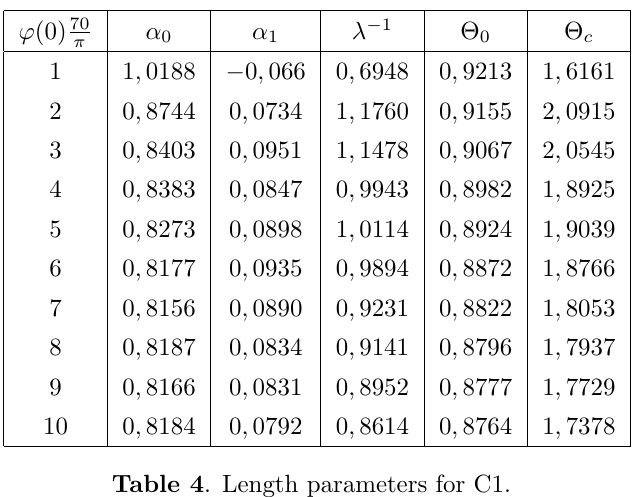
Table 4 . Length parameters for C1.